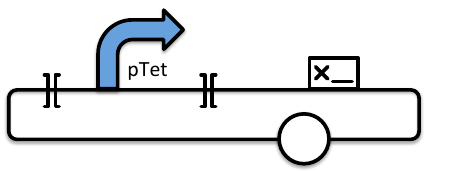
Figure 31: Promoter stored in a plasmid as in Figure 30, except that the restriction sites before and after the promoter are blunt-end.